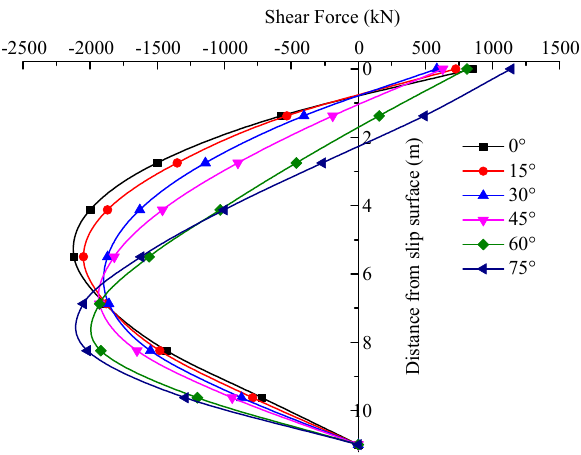
Figure 21. Bending moment of the embedded section of the stabilizing pile.